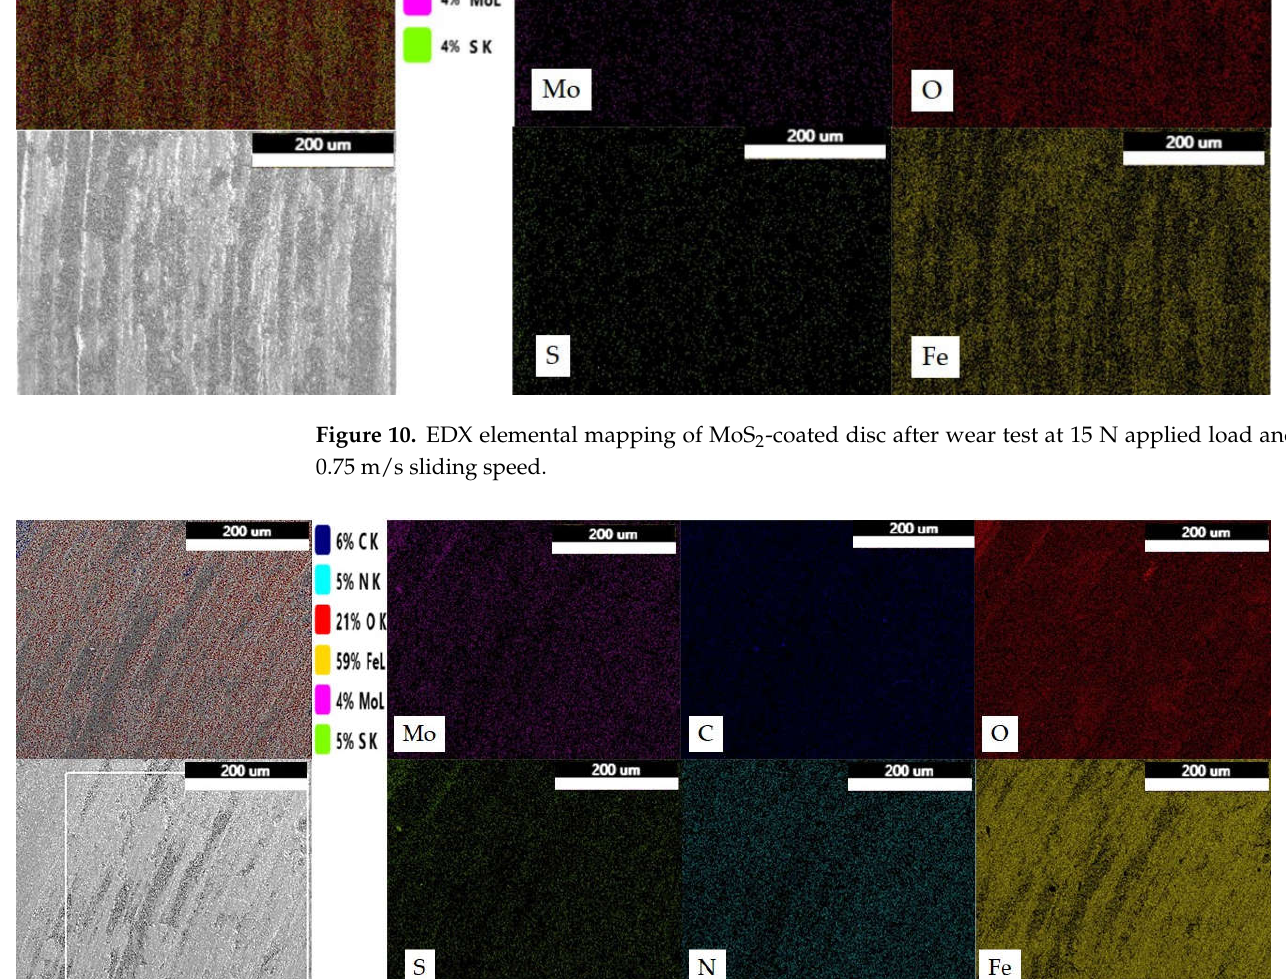
Figure 11. EDX elemental mapping of g-C 3 N 4 /MoS 2 (9 wt.%) nanocomposite coated disc after wear test at 15 N applied load and 0.75 m/s sliding speed.